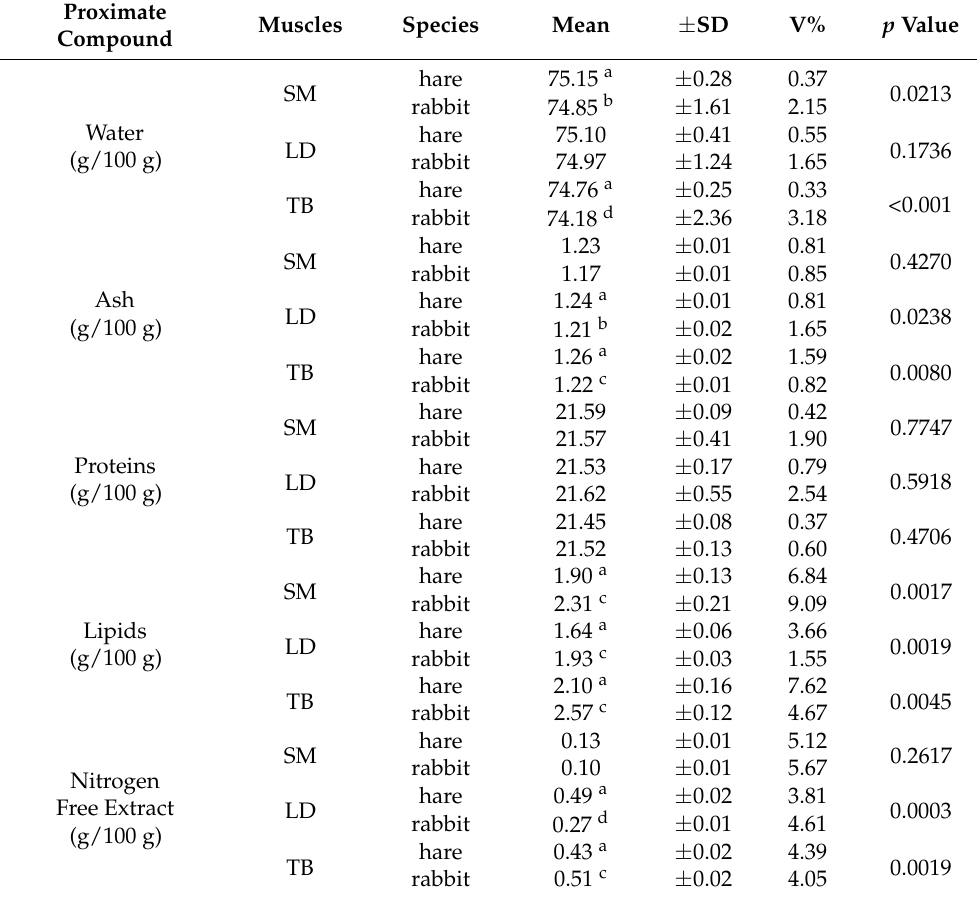
Table 1. Proximate composition of hare and rabbit meat (g/100 g).